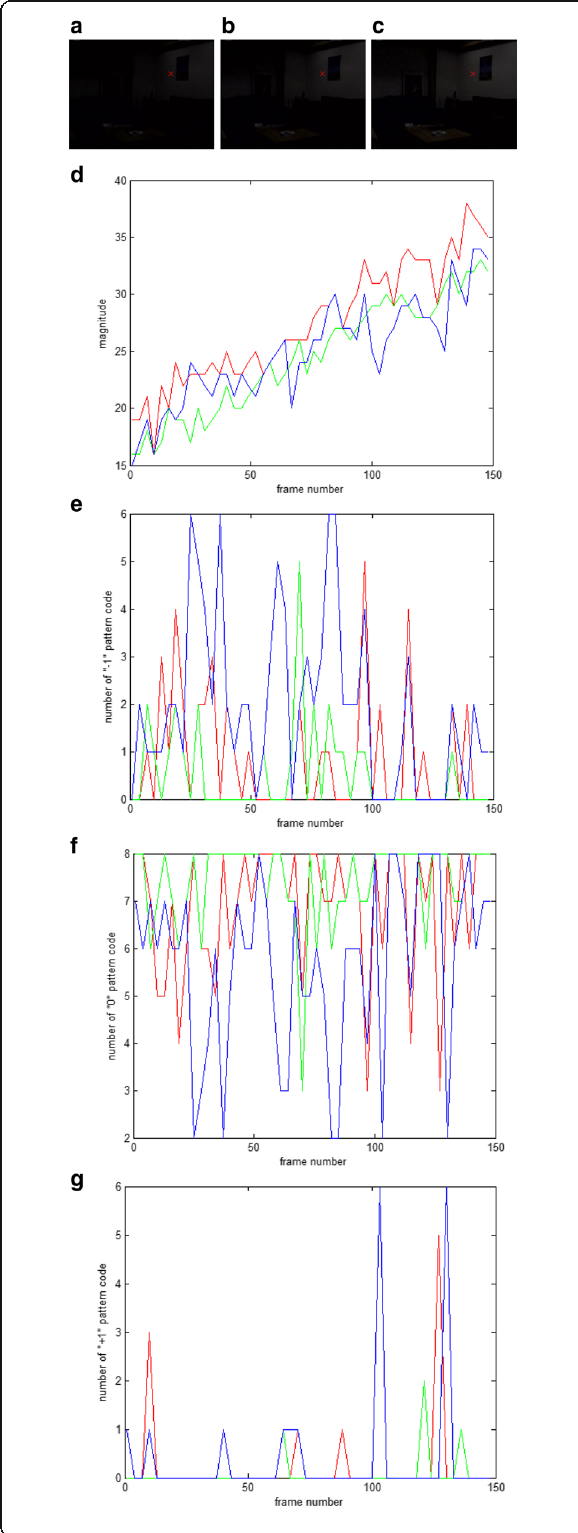
Fig. 4 Frames of an image sequence and plots of pixel values and P-LTP features for three color components (in red, green, and blue lines). a Frame 0. b Frame 74. c Frame 149. d Magnitudes of R , G , and B versus frame number. e Cardinality of “ − 1 ” pattern code. f Cardinality of “ 0 ” pattern code.